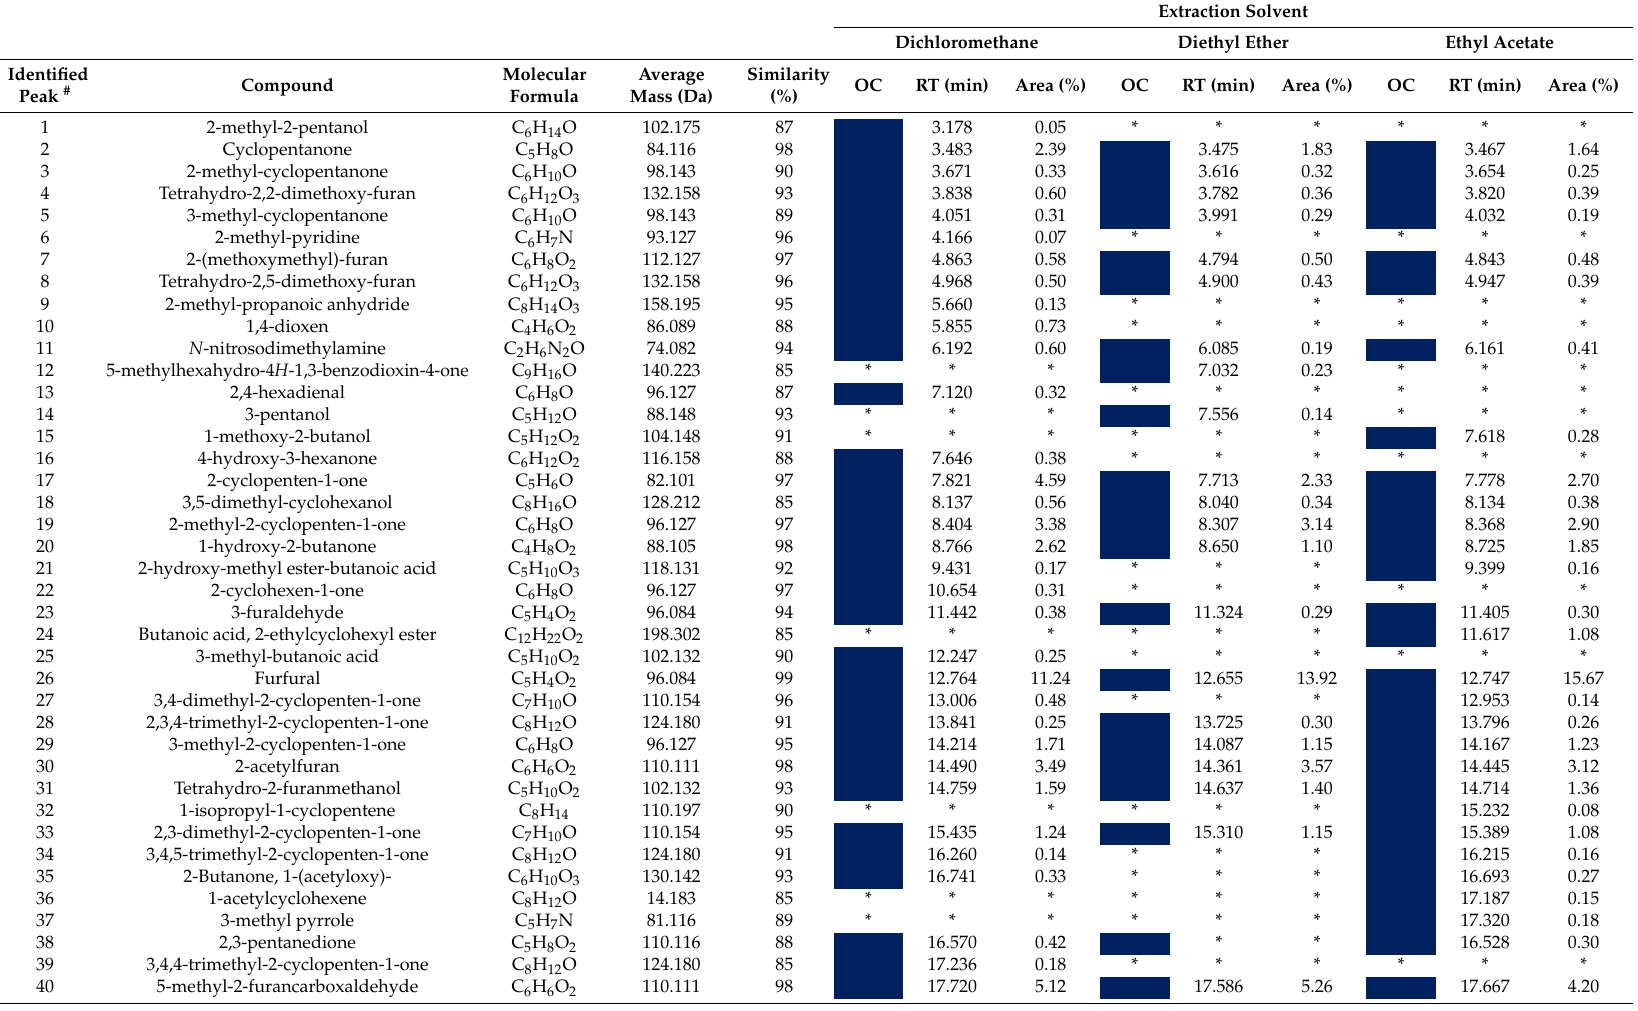
Extraction Solvent Diethyl Ether Ethyl Acetate